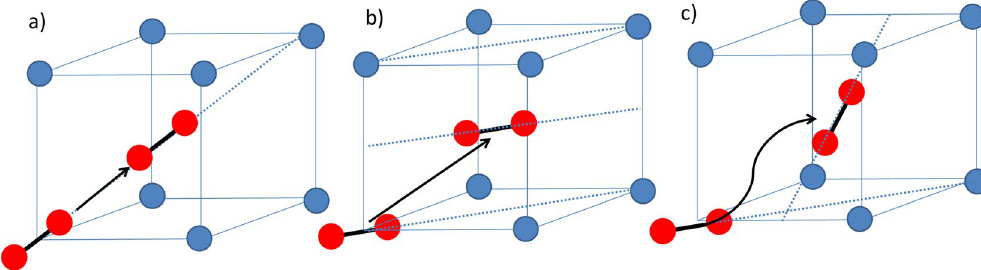
Figure 1. Schematic showing: ( a ) Diffusion of a < 111 > crowdion in the close-packed < 111 > direction in the BCC structure as described by the 1-D SIA model; ( b ) diffusion of a < 110 > dumbbell in the (110) plane as described by the 2-D SIA diffusion model; and ( c ) forbidden rotation of a < 110 > dumbbell onto the (011) plane which would give rise to 3-D SIA